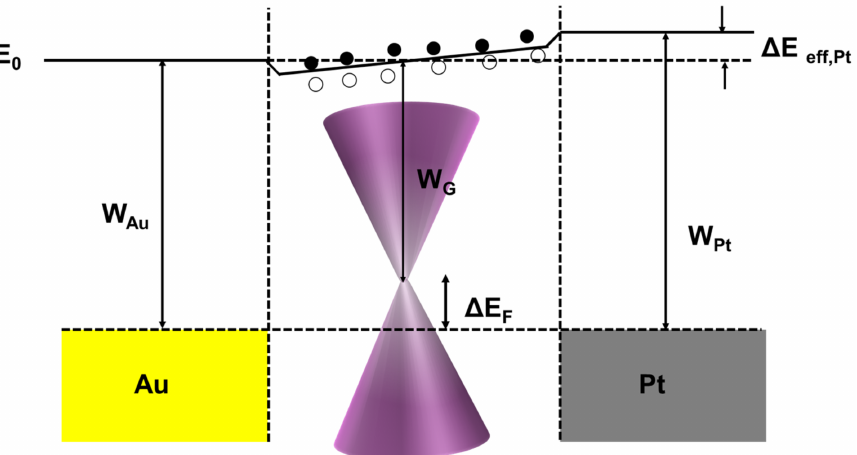
Figure 10. Schematic diagram of the Au/graphene/Pt band structure. W Au : Au work function, and W Pt : Pt work function. E 0 is the vacuum level, and ∆ E F represents the doping state of the graphene channel. The black-filled (empty) circle is an electron (hole) generated by light absorption.